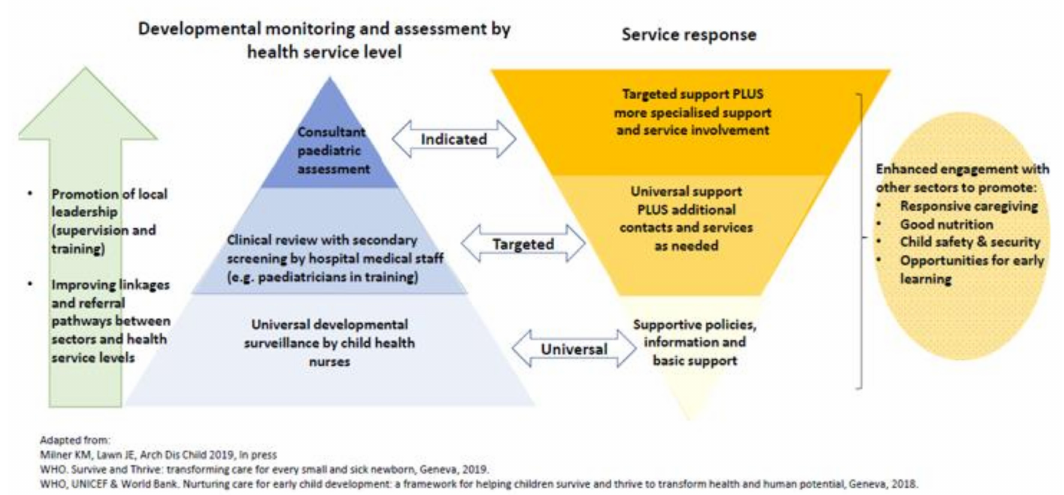
Figure 2. Strengthening health systems in developmental paediatrics in